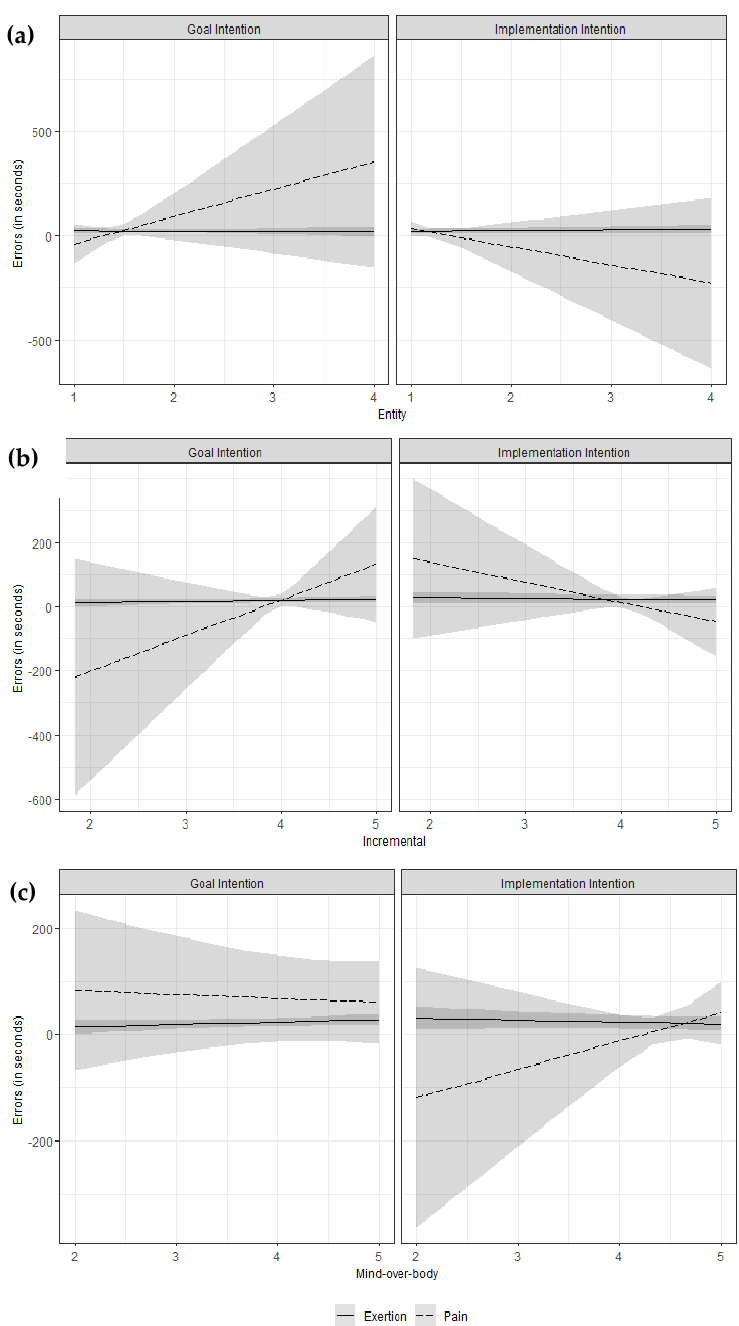
Figure A2. Estimated errors as a function of Condition (goal vs. if-then plan), Limit (reason for task termination: exertion vs. pain) and ( a ) entity beliefs, ( b ) incremental beliefs and ( c ) mind-over-body beliefs. Higher values of entity beliefs represent a stronger belief that athletic ability is stable and fixed, while higher values of incremental beliefs represent a stronger belief that athletic ability is changeable by effort and training. Finally, higher values of mind-over-body beliefs represent a stronger belief that the mind (i.e., mental factors) rather than then the body (i.e., physical factors) limits athletic performance.